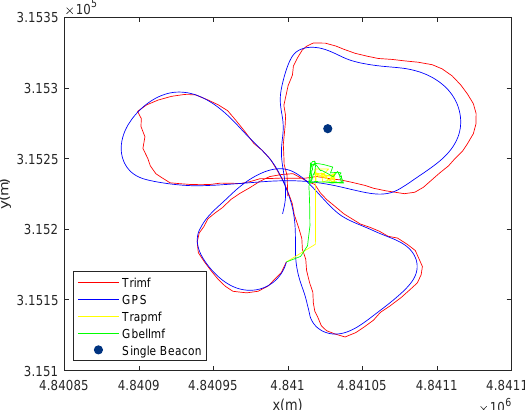
Figure 11. Comparsion of different membership function